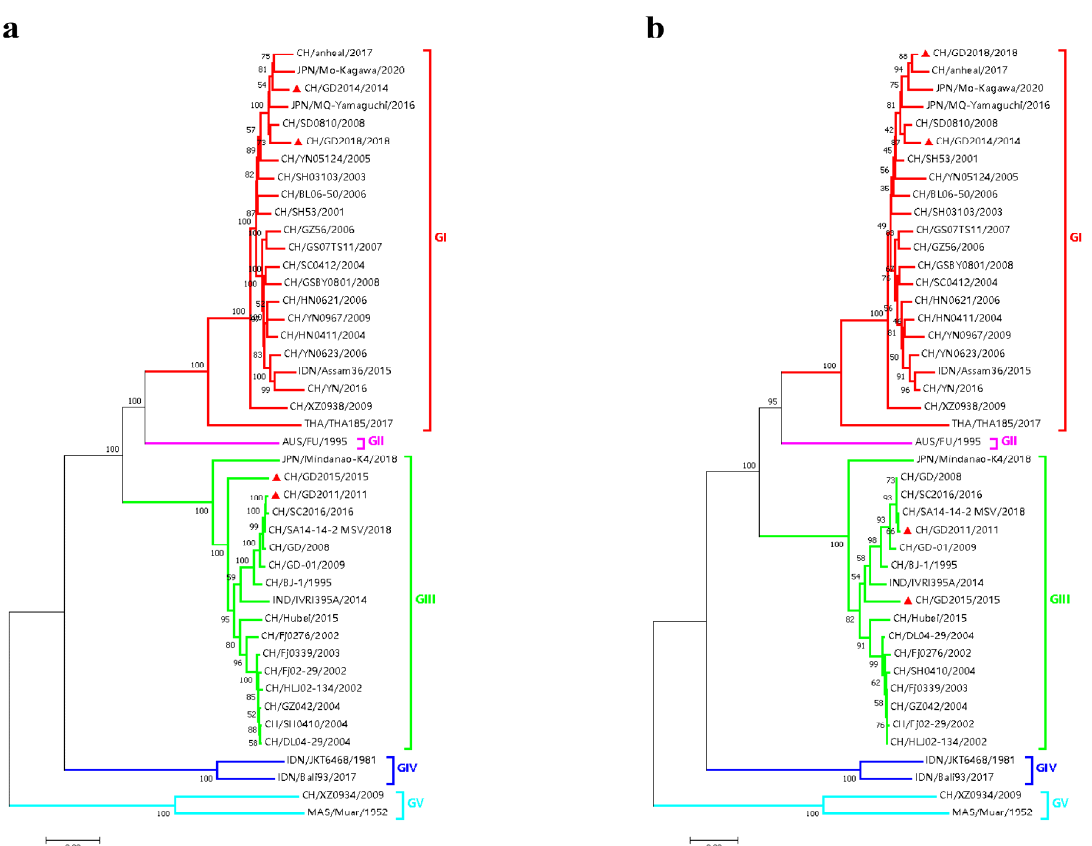
Figure 4. Evolutionary tree of JEV isolates. ( a ) Genomic phylogenetic relationship analysis of JEV isolates; ( b ) phylogenetic relationship analysis of the E gene of JEV isolates (the π in the picture is the isolate in this study.).